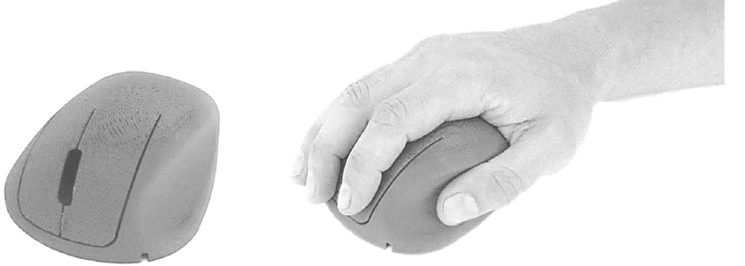
Figure 3. ch concept mockup (male adult hand, length 190 mm, width 88 mm, corresponding respectively to 40th and 50th percentile, according to Gordon et al. [26]).